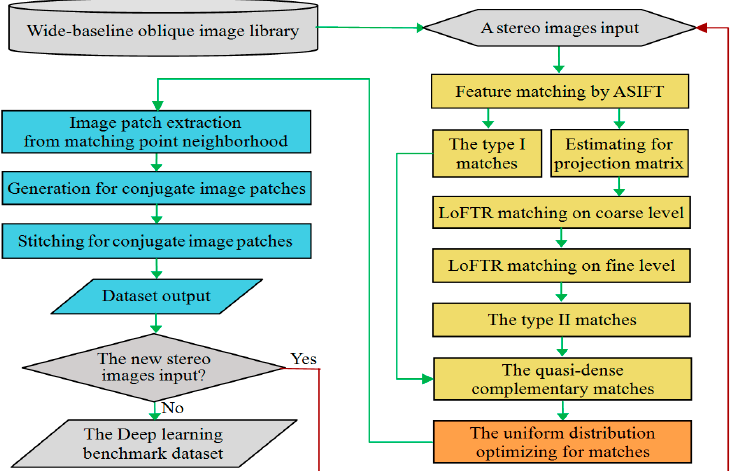
Figure 1. Flowchart for the automatic production of an affine-invariant feature-matching dataset.